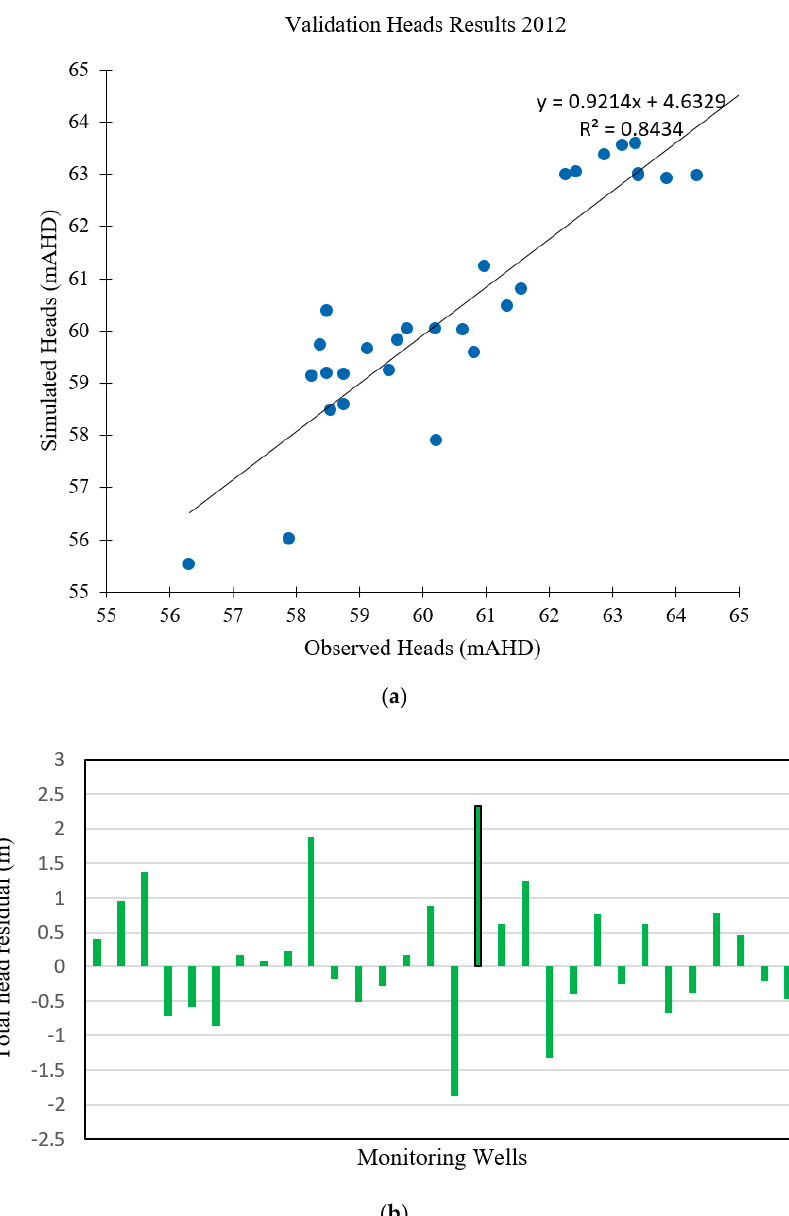
Figure 6. ( a ) Correlation between observed and simulated groundwater levels during the validation period. ( b ) Errors between observed and simulated hydraulic heads during the validation period (2014).